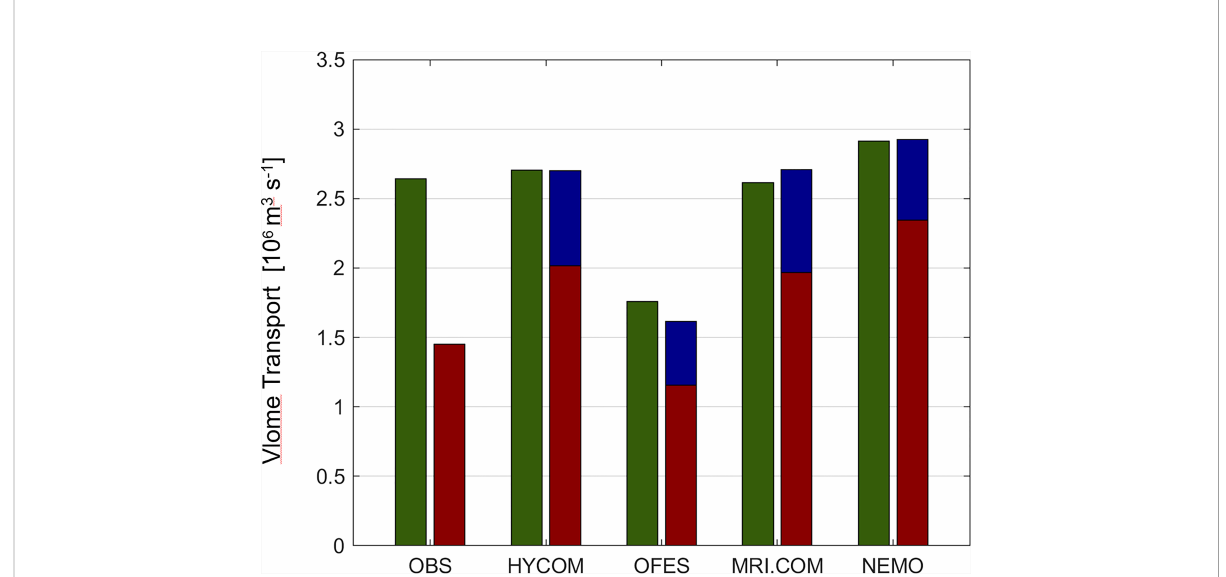
similar mean values and consistent spread. Note that a few outlier values of ADCP between − 0.3 and − 0.4 cm s − 1 are not included in this histogram.